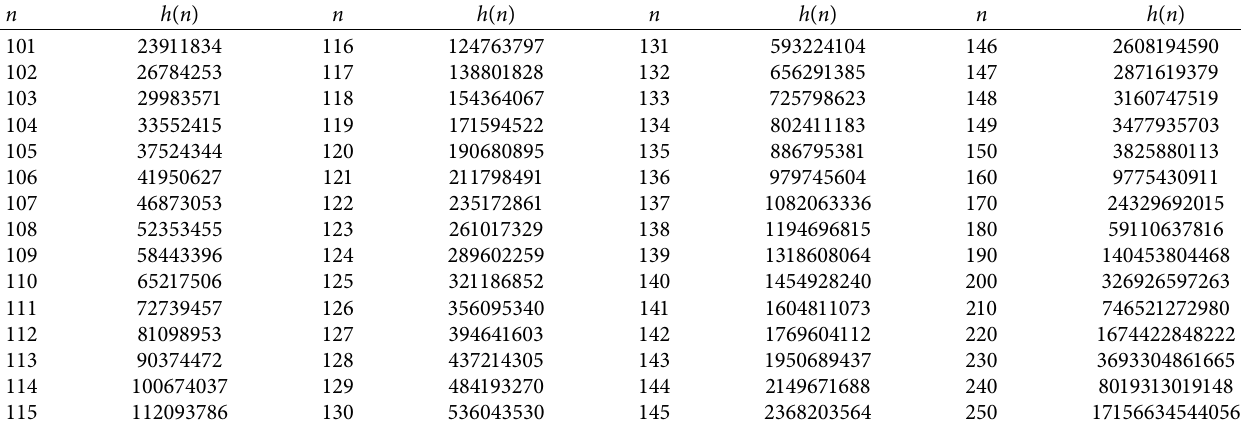
Table 2: The value of h ( n ) when 101 ≤ n ≤ 250.